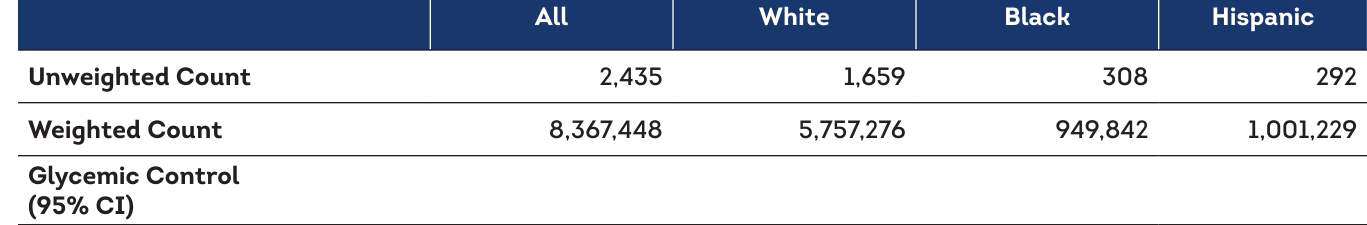
Table A5: Knowledge of diabetes self-management and Medicare coverage, by race/ethnicity All White Black Hispanic